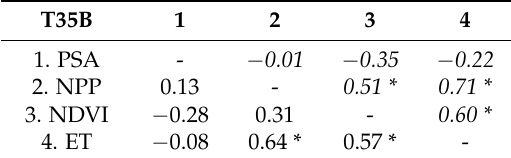
Table 3. Catchment level correlation between PSA, NPP, NDVI and